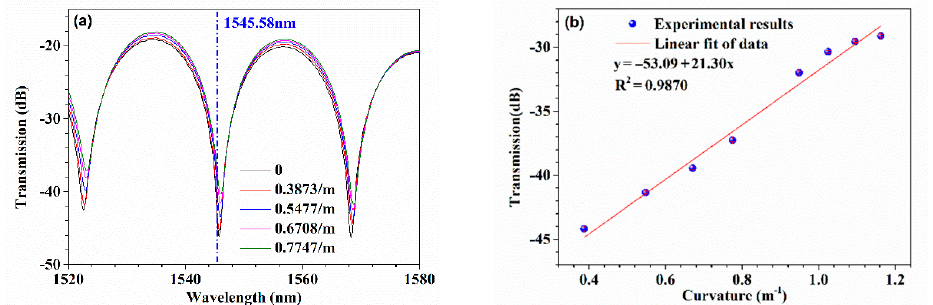
Figure 5. Bending response of the proposed sensing structure. ( a ) Transmission spectra of the device with typical curvatures. ( b ) The relationship between the transmission and the curvature of the device for a single wavelength light.